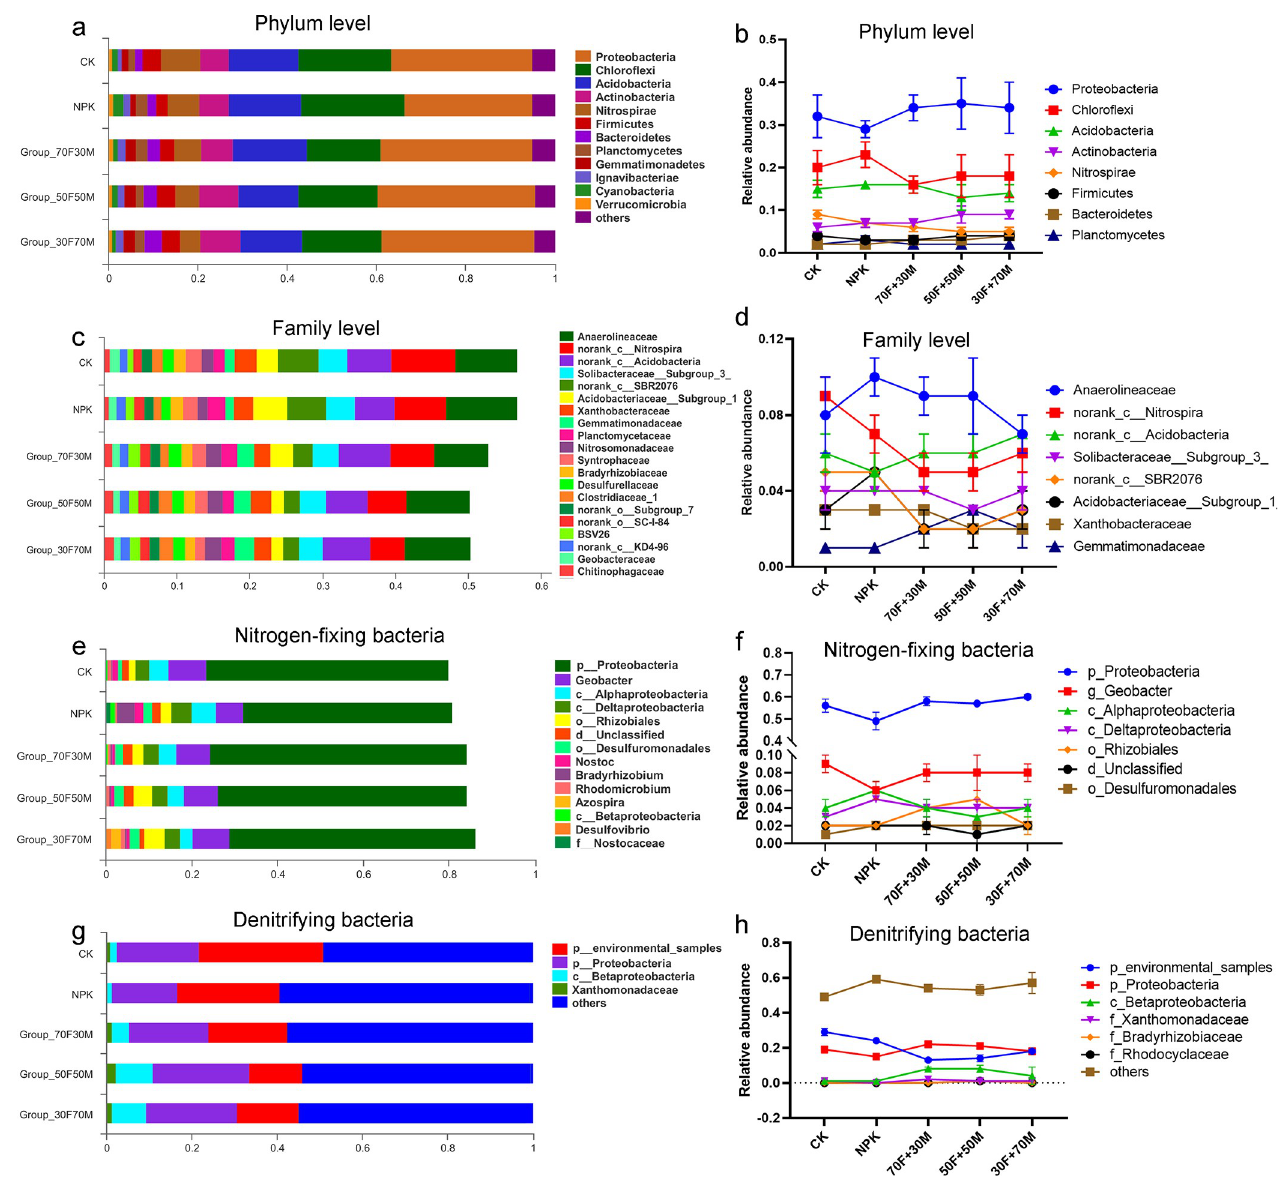
Fig 3. Impacts of various fertilizers on bacterial community. ( a ) Proportion changes in phylum level. ( b ) Relative abundance in phylum level. ( c ) Proportion changes in family level. ( d ) Relative abundance in family level. ( e ) Proportion changes of nitrogen-fixing bacteria. ( f ) Relative abundance of nitrogen-fixing bacteria. ( g ) Proportion changes of denitrifying bacteria. ( h ) Relative abundance of denitrifying bacteria.